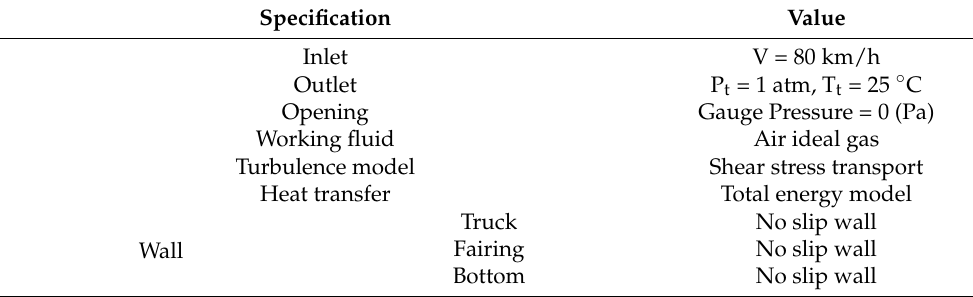
Table 4. Boundary condition for CFD analysis.